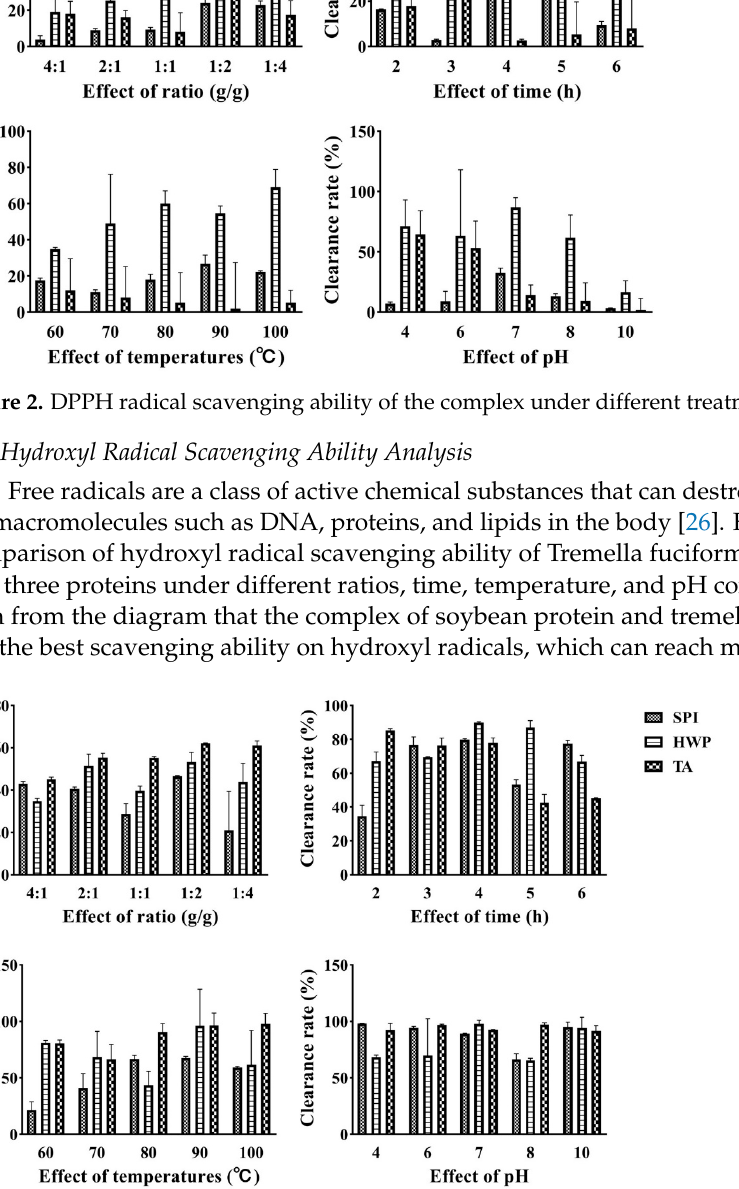
Figure 1. Grafting degree of complex under di ff erent treatment conditions.